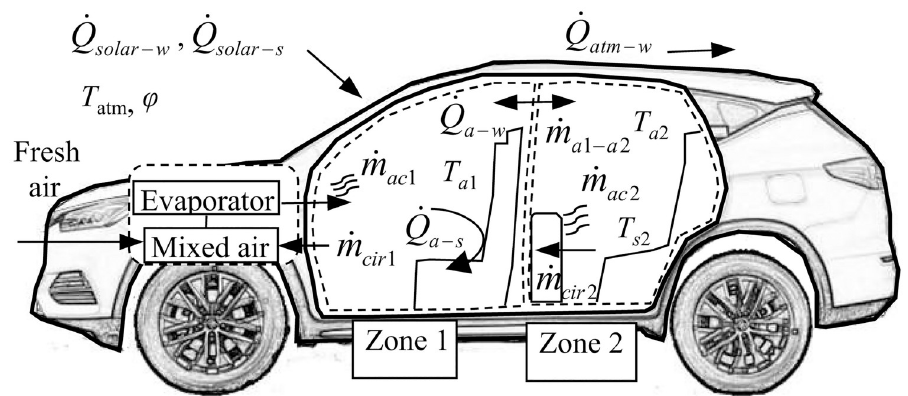
Fig 4. The physical relationship of cabin thermal transfer. Solar radiation ( Δ Q solar − w , Δ Q solar − s ) is an important factor to the cabin temperature, the convection of external airflow ( Δ Q ) as well. As the uneven airflow from atm − s HVAC, the cabin is divided into two thermal zones: the front row’s region (zone 1) and the rear row’s region (zone 2). During cooling, thermal zones are affected by energy and mass exchanges: 1) the convection ( Δ Q , Δ Q ) and a − w a − s cooling mass flow ( Δ m ac ) from air-conditioning; 2) the solar radiation load ( Δ Q solar − w , Δ Q solar − s ) received; 3) air circulation between zones ( Δ m ) and in HVAC ( Δ m ); 4) thermal exchanges with outside ( Δ Q a 1 − a 2 cir atm − s